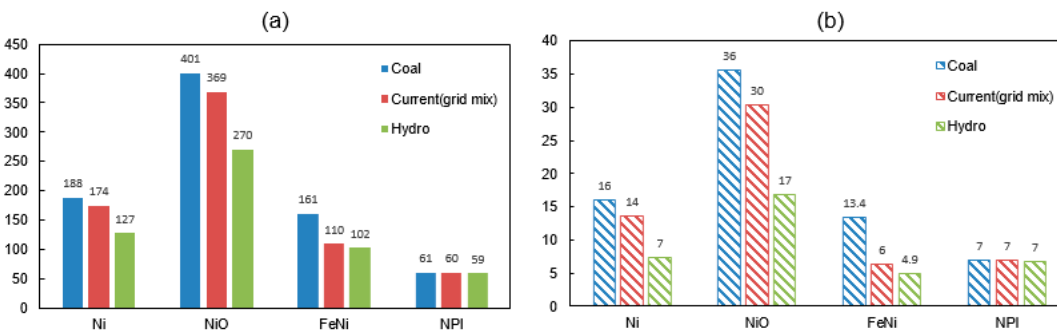
Figure 3. ( a ) Energy consumption (GJ/t alloy) and ( b ) GHG emissions (tCO 2 -eq/t alloy) of nickel alloy production with different scenarios of electricity (Blue: 100% coal-electricity; Red: grid-mix; Green: 100% hydro-electricity).